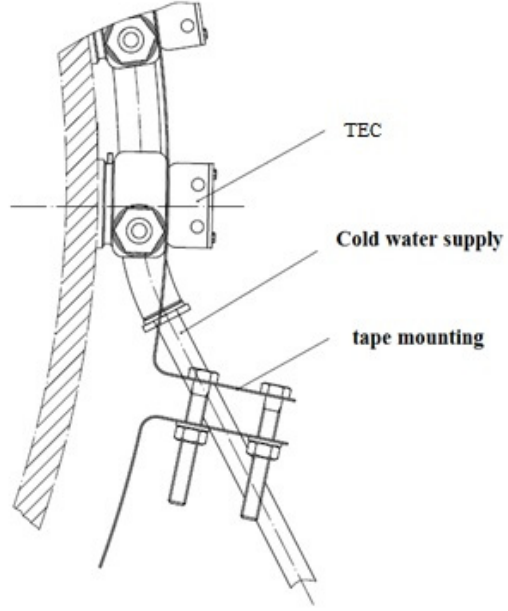
Figure 9. Method of fastening the gas cooling system to the flue pipe.